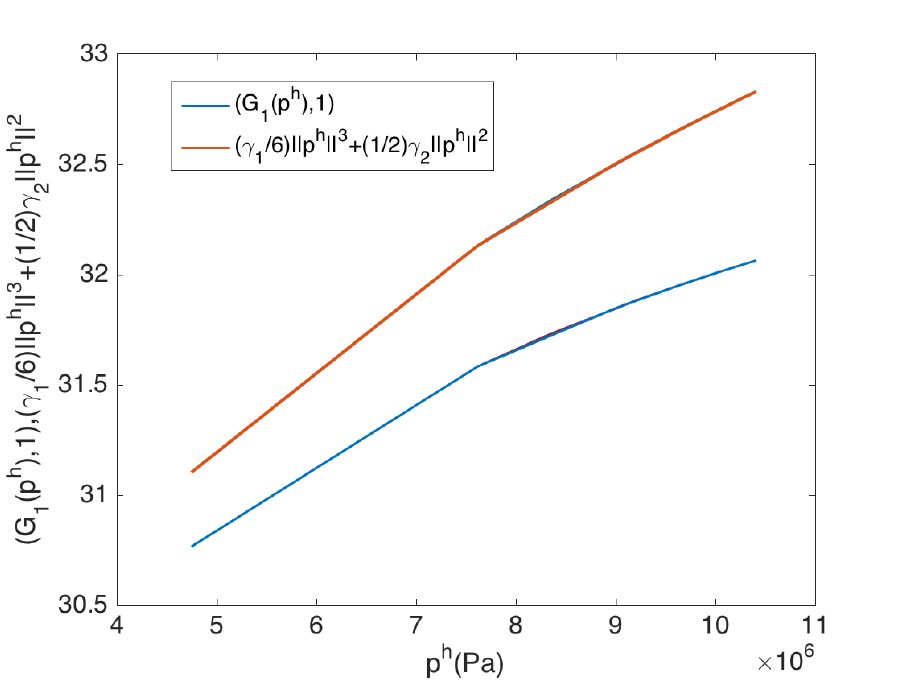
Figure 2. Numerical verification for the theoretical results in Lemma 2.